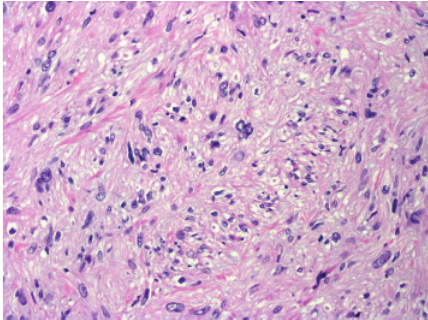
Figure 2: Spindled cells showing smooth muscle differentiation with cytologic atypia, H&E 20x.